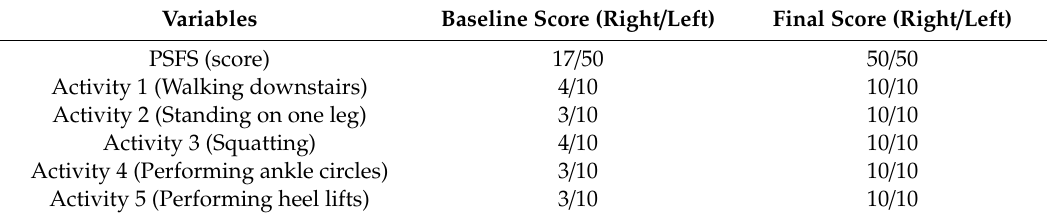
Table 2. Outcomes of the patient-specific functional